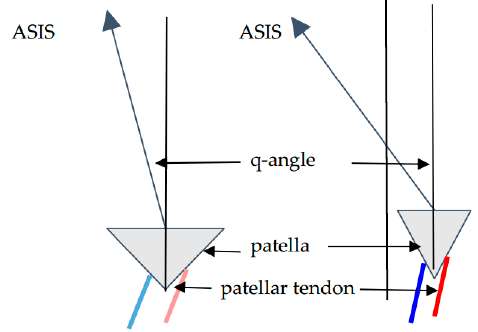
Figure 1. Relationship between the q-angle, patella and the patellar tendon. Anterior superior